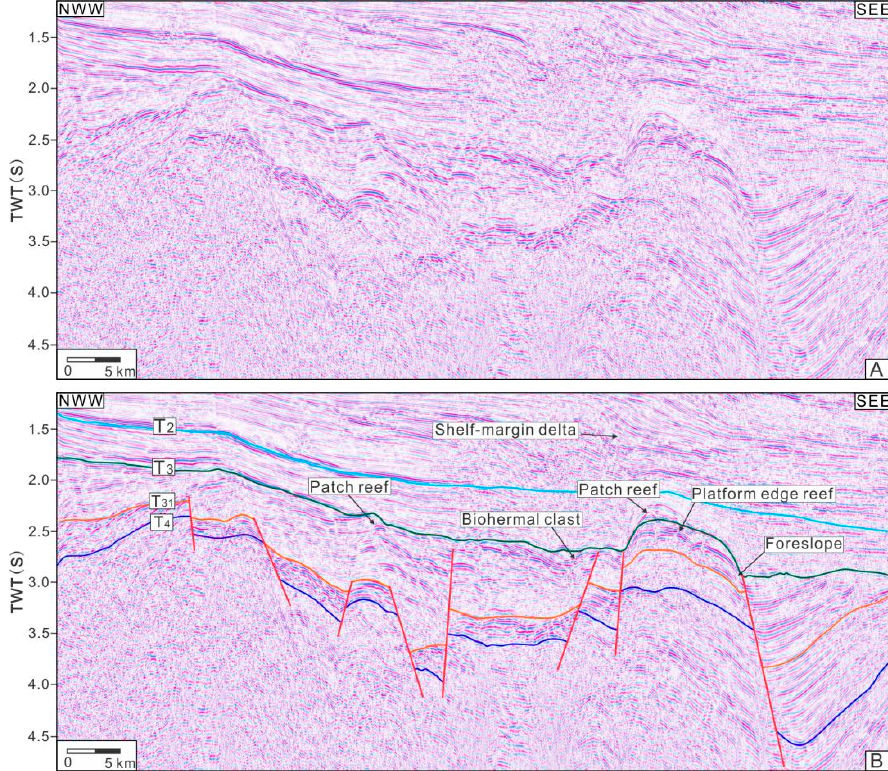
Figure 6. ( A ) Seismic profile of RCPs in north of Wan’an Basin. ( B ) Seismic profile of RCPs in north of Wan’an Basin with annotation. Profile location is shown in Figure